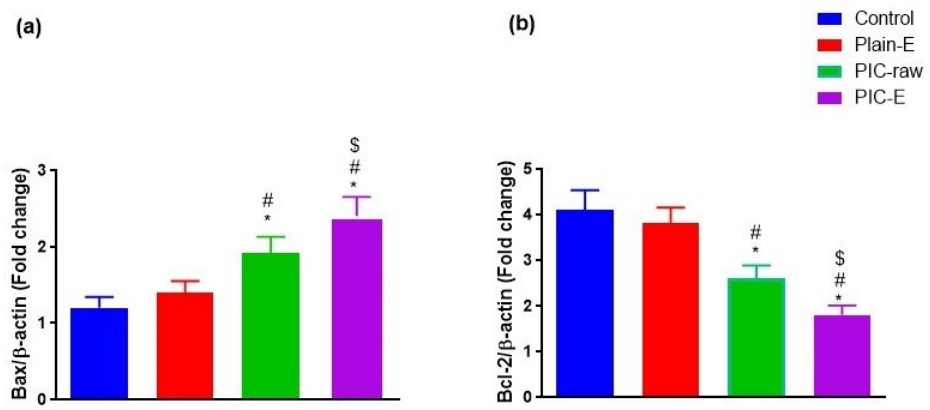
Figure 10. Effect of PIC-E on Bax and Bcl-2 mRNA expression content in HCT 116 cells; cells were incubated for 24 h with plain-E, PIC-raw (0.1 µM), or PIC- E (equivalent to 0.1 µM PIC) * Significantly different from control at p < 0.05. # Significantly different from plain-E at p < 0.05. $ Significantly different from PIC-raw at p < 0.05.